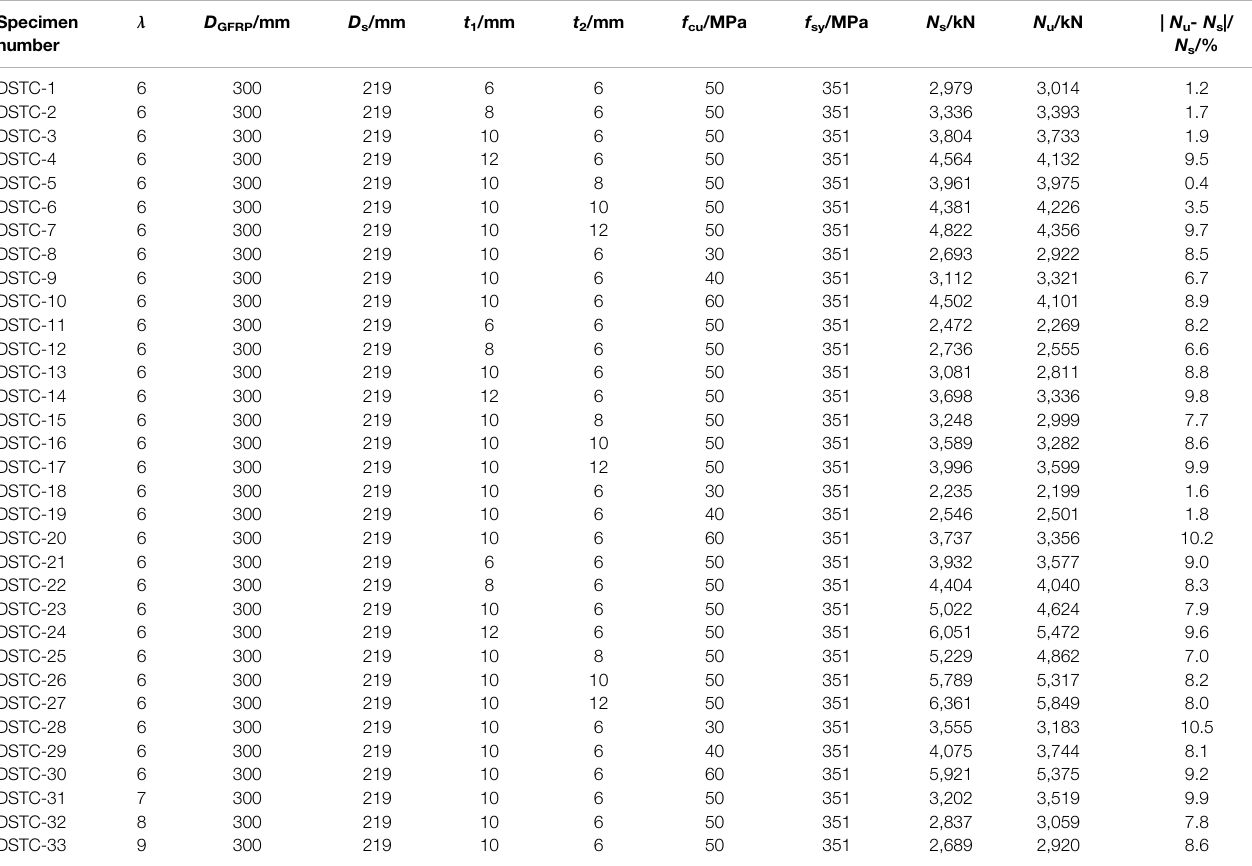
TABLE 9 | Comparisons of N s and N u for 33 composite columns. Specimen number